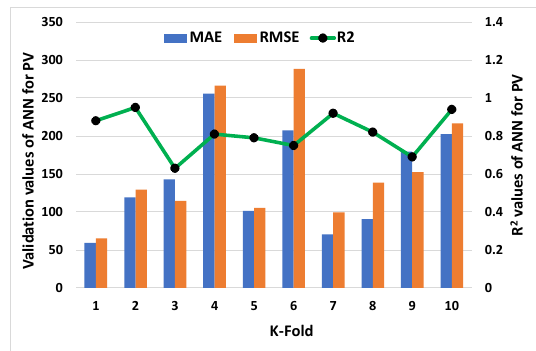
Figure 11. K-fold result of plastic viscosity from ANN model.